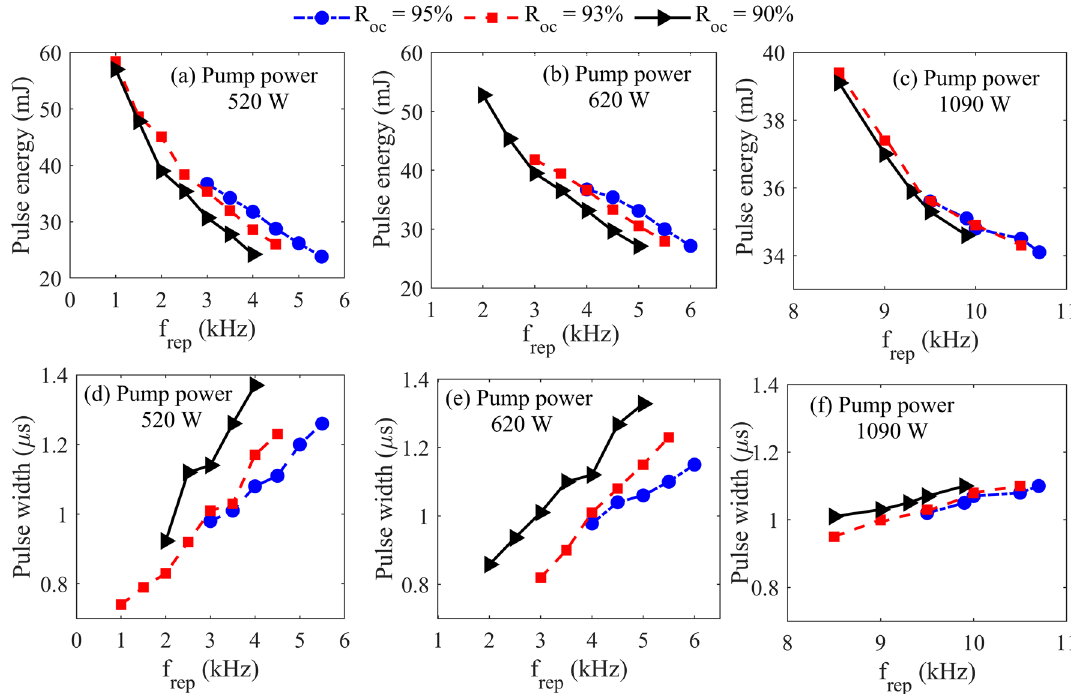
Figure 2. The energy and pulse width of output pulses as a function of repetition rate under the pump power of ( a,d ) 520 W, ( b,e ) 620 W, and ( c,f ) 1090